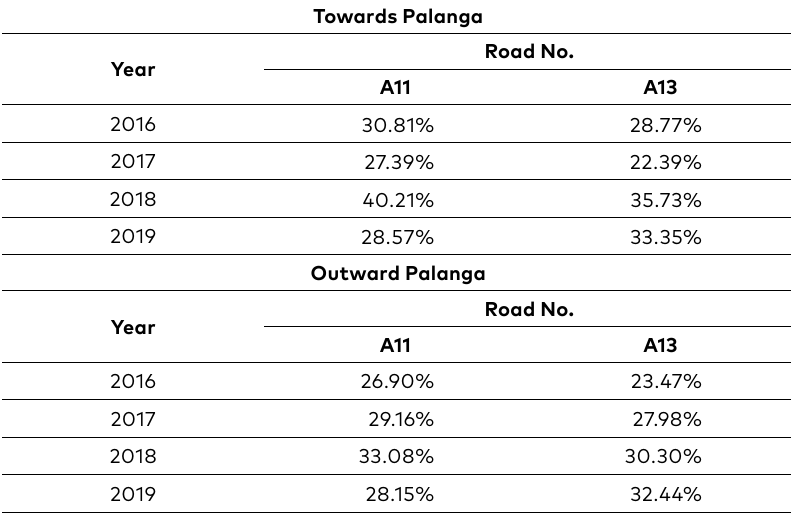
and outward Palanga during “Palanga Stint” and a regular